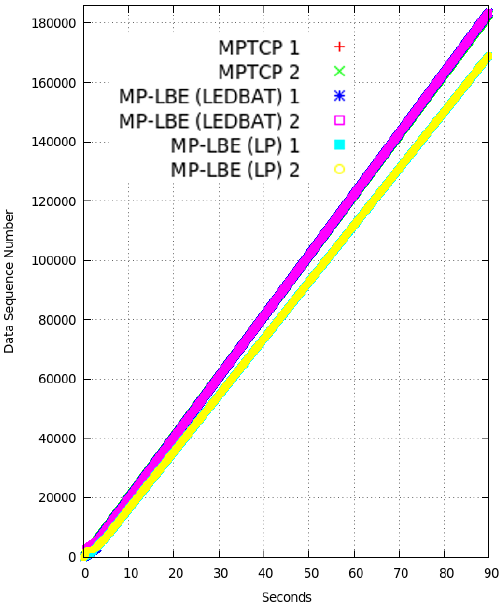
Figure 7. Data Sequence Numbers received at the destination node plotted against time.